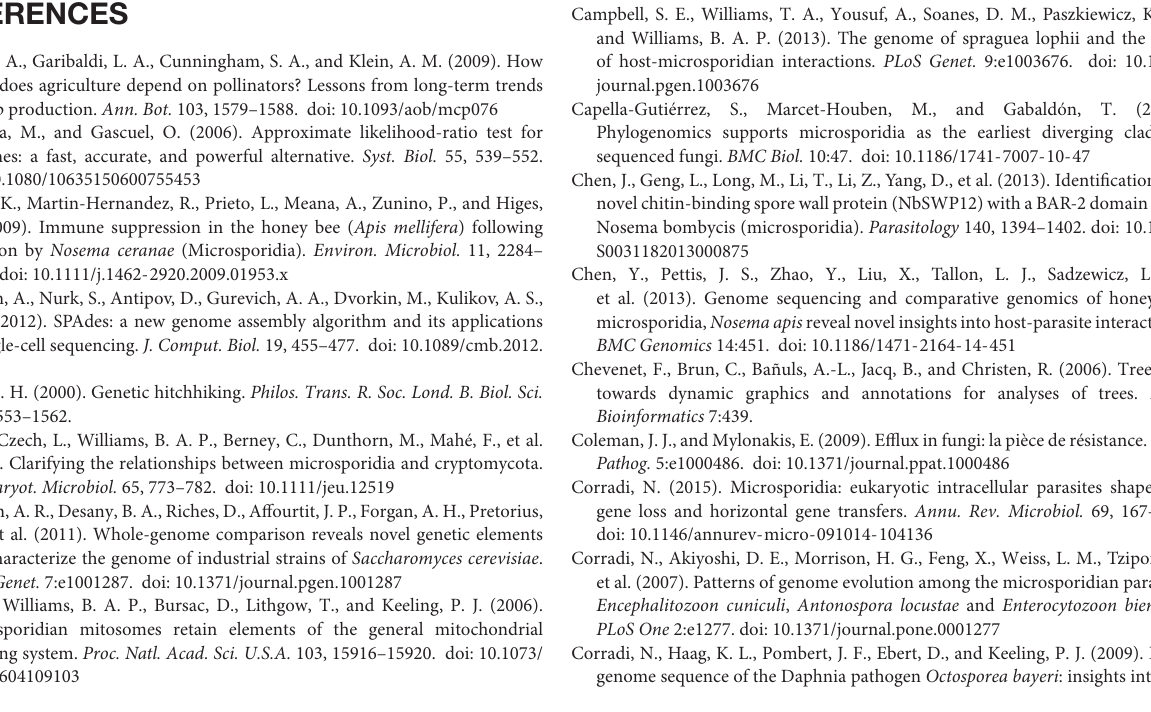
Supplementary File 2 | De novo transcriptome assembly. Supplementary File 3 | Genes in SVs. Supplementary File 4 | Sequences for microsporidian phylogenetic tree of Figure 2 . Supplementary File 5 | Sequences for Dicer phylogenetic tree of Figure 4A . Supplementary File 6 | Sequences for Dicer up and down stream phylogenetic tree of Figure 4B . Supplementary File 7 | Sequences for ISU1 phylogenetic tree of Figure 5 . Supplementary File 8 | Sequences for NFS1 phylogenetic tree of Figure 6 . Supplementary File 9 | Sequences for HSP1 phylogenetic tree of Figure 7 . Supplementary File 10 | Sequences for ABC phylogenetic tree of Figure 8 . Supplementary File 11 | Sequences for ATP phylogenetic tree of Figure 9 . Supplementary File 12 | Sequences for PTP synteny of Figure 10